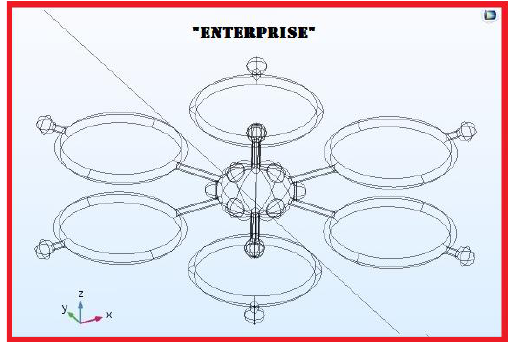
Figure 13. Enterprise, from a COMSOL 3D perspective.